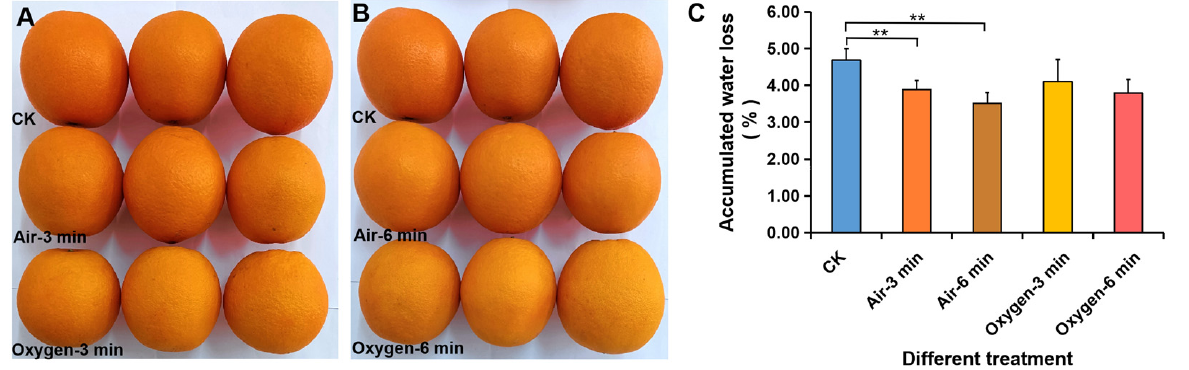
Figure 9. Inhibition of water loss of navel orange fruit by low-temperature plasma treatment. ( A , B ) The phenotypes of navel oranges without treatment (CK) and treated with low-temperature plasma produced by ionization of air and oxygen for 3 min ( A ) or 6 min ( B ). ( C ) The total water loss per fruit for untreated navel oranges (CK) and treatment with low-temperature plasma produced by ionization of air or oxygen for 3 or 6 min. The error bars represent the mean ± SD ( n = 10). **, p < 0.01.